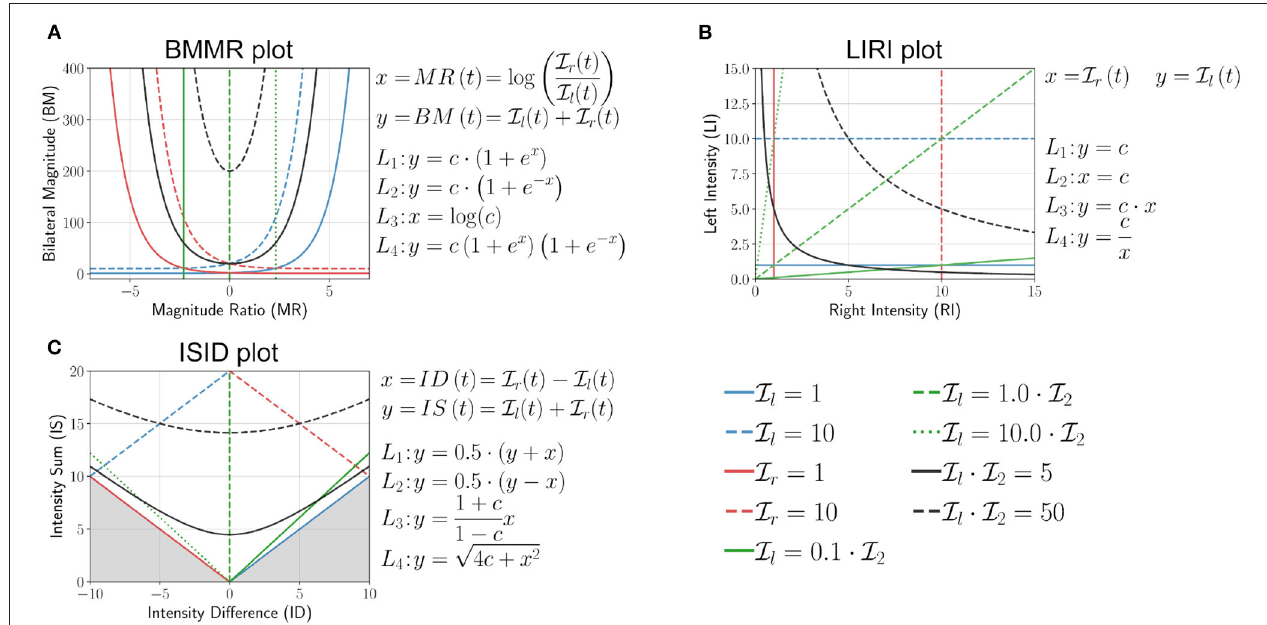
FIGURE 6 | Analysis of (A) bilateral magnitude vs. magnitude ratio (BMMR) plot (Bailey et al., 2014), (B) left intensity vs. right intensity (LIRI) plot (David et al., 2020), and (C) intensity sum vs. intensity difference plot (ISID), by investigating the nature of the family of four curves L 1 (blue), L 2 (red), L 3 (green), and L 4 (black) introduced in Equation (11). The solid and dashed lines indicate different values of c for the same